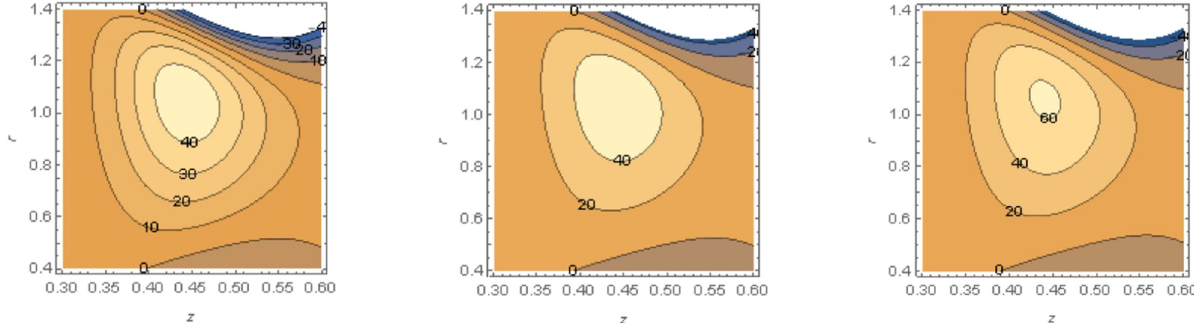
Figure 18: Various values of the wave frame streamlines of ∅ = { 0.160, 0.165, 0.170 } at W